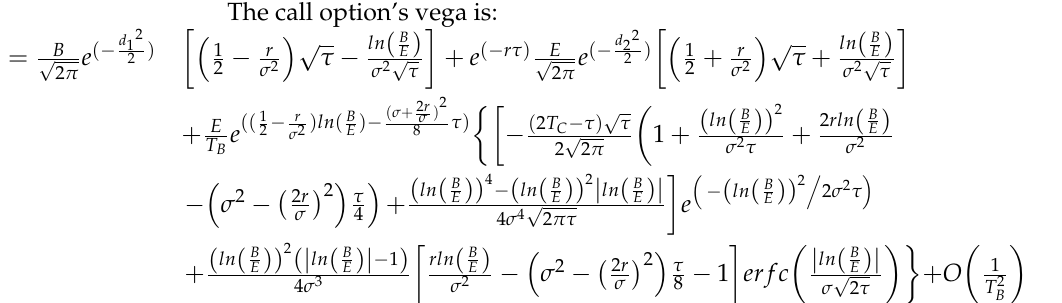
Figure 6. PTP thetas at different volatilities.